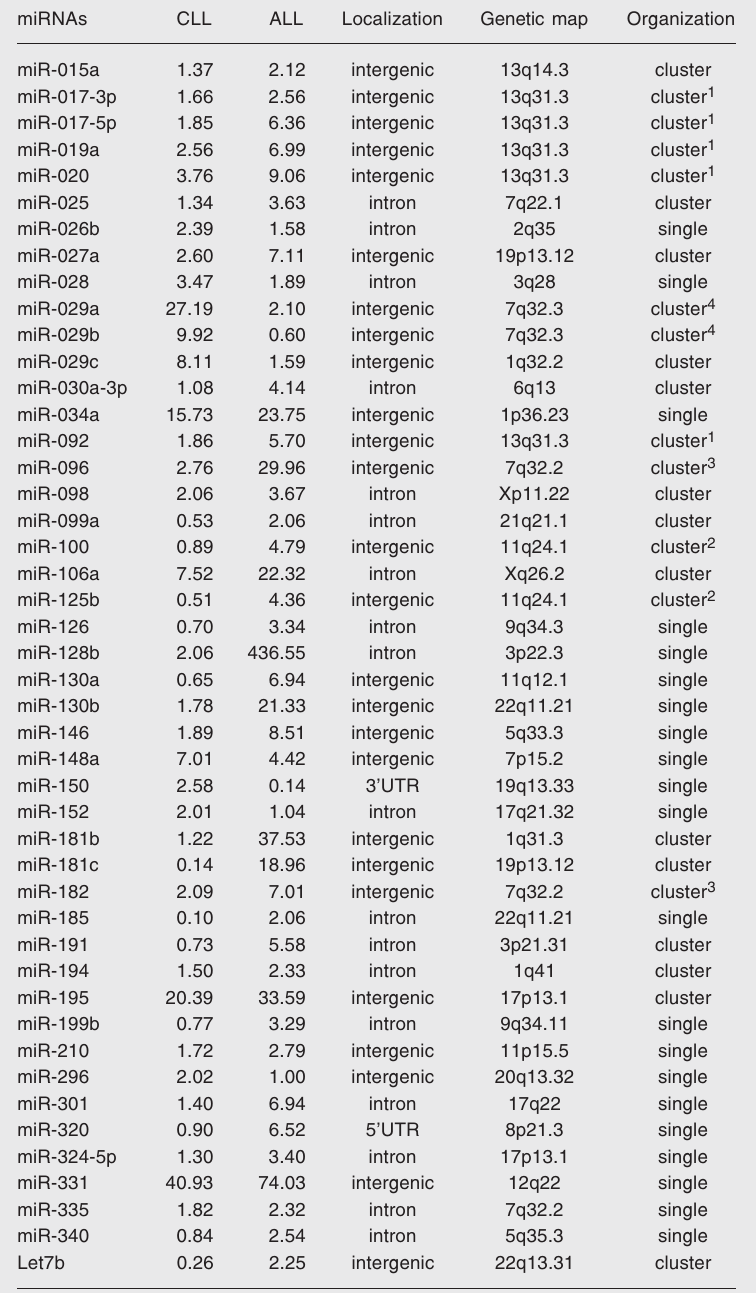
Table 1. Relative expression of 46 microRNAs (miRNAs) in chronic and acute lympho- cytic leukemia (CLL and ALL). miRNAs CLL ALL Localization Genetic map